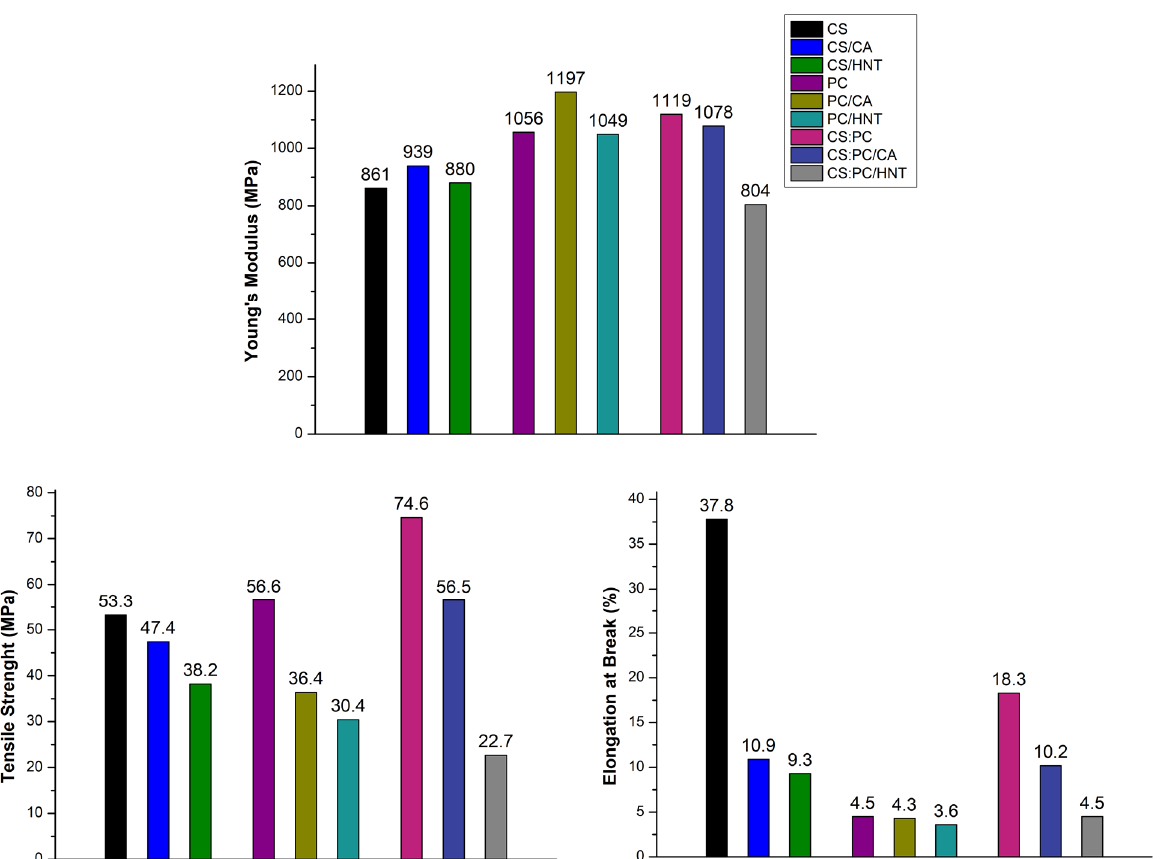
Figure 2. Main mechanical properties of all investigated samples.